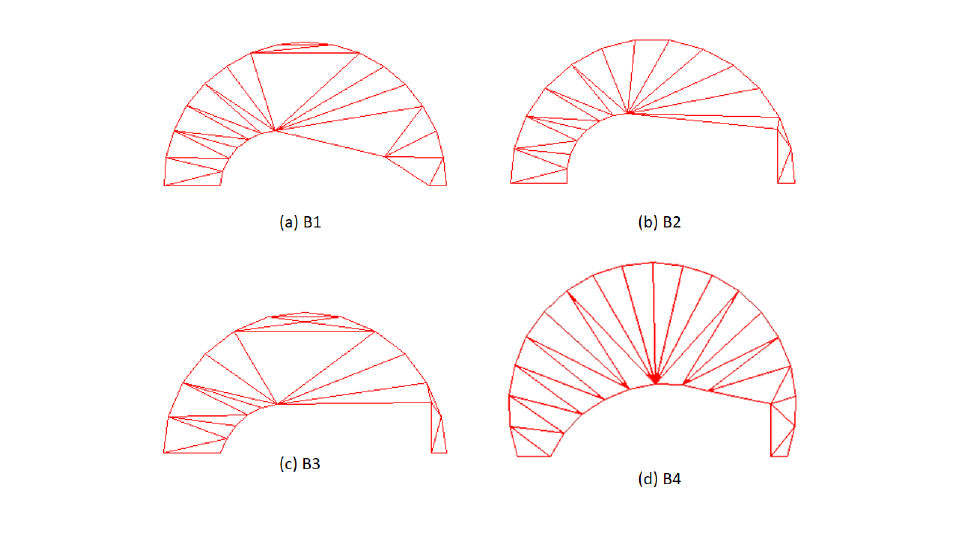
Figure 1. Designed lenses by modifying inner and outer curvatures and